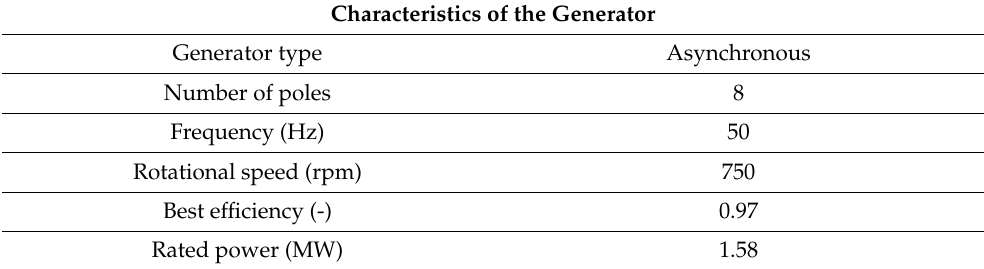
Table 11. Characteristics of the generator selected.